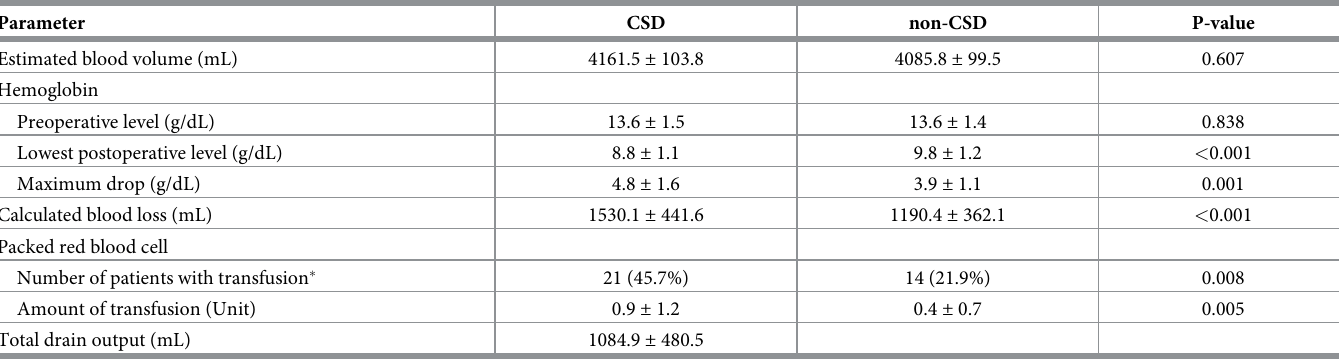
Table 2. Hemoglobin level, blood loss, and transfusion.